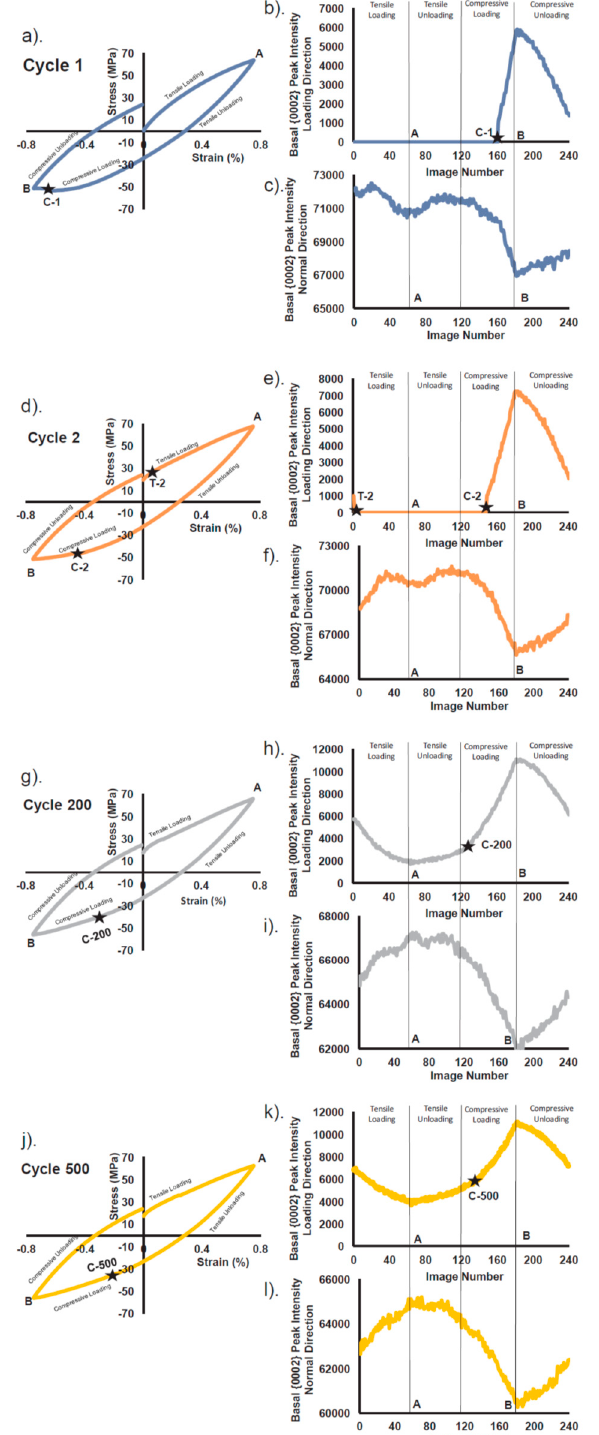
Figure 30. The cyclic response of pure Mg samples during the cyclic loading with a strain amplitude of 0.75% along the extrusion direction, including the stress-strain loops and variations of basal { 0 0 0 2 } peak intensity along with loading and normal directions during the cyclic loading ( a – c ) Cycle